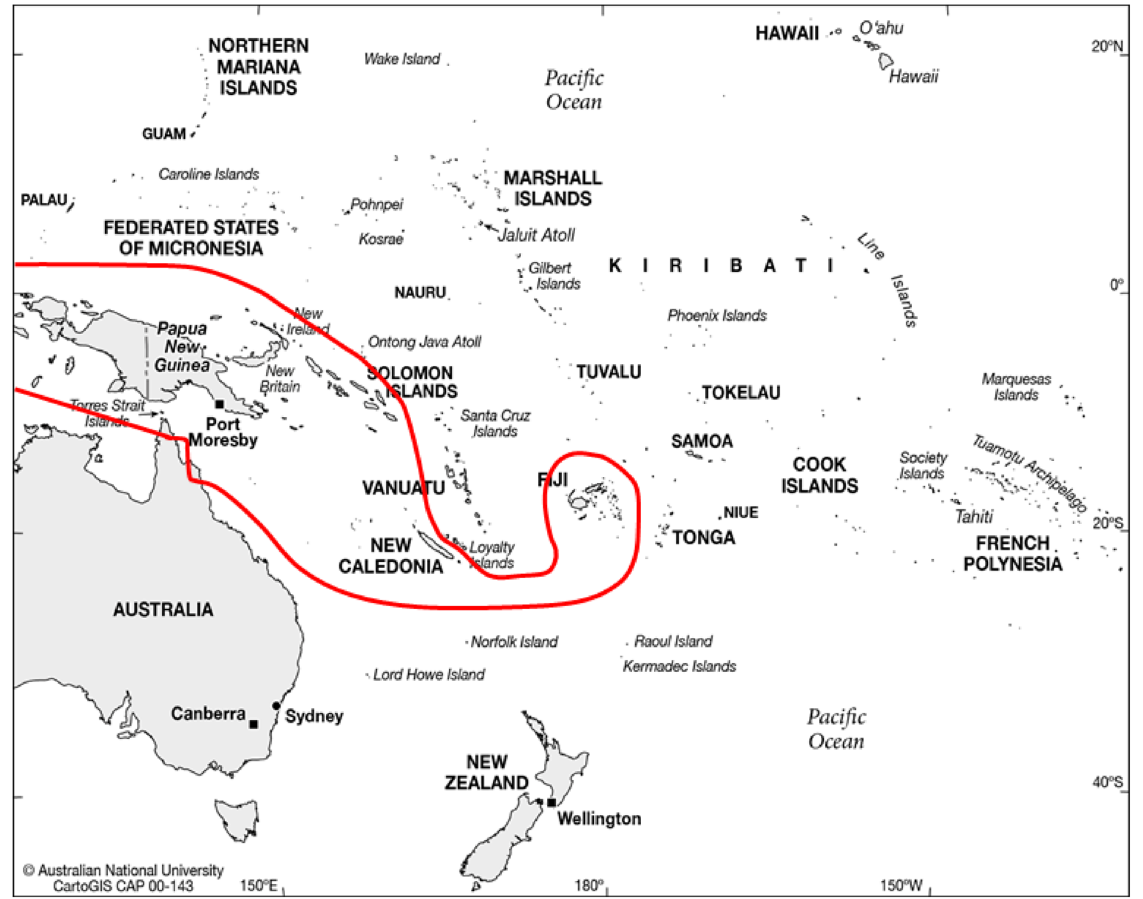
Fig. 19. Regional distribution of the genus Xylopia (Annonaceae) in the Pacific. Base map sourced from CartoGIS, College of Asia and the Pacific, The Australian National University,